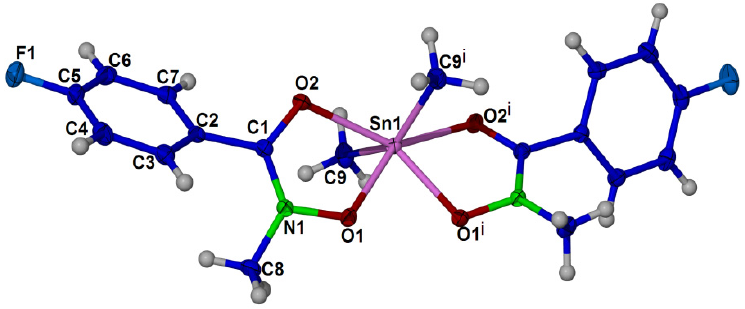
H F N O Sn (compound 2 ). Displacement 24 32 2 2 4